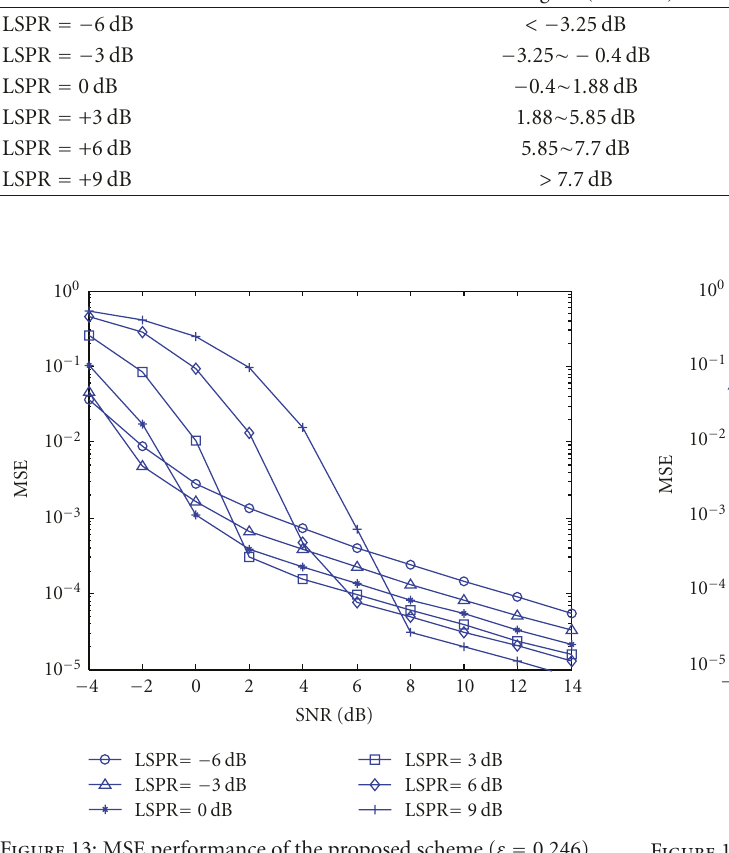
Figure 14: MSE performance of the proposed scheme ( ε = 0 .